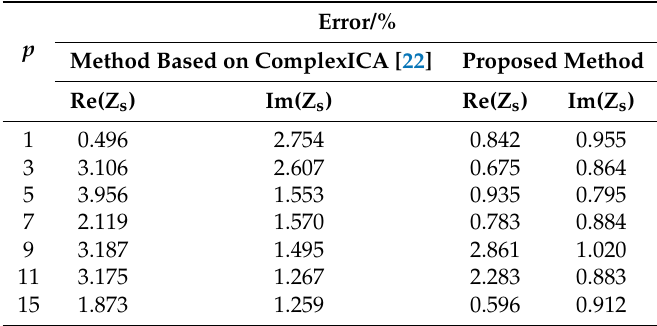
Table 3. Errors of two methods for different p